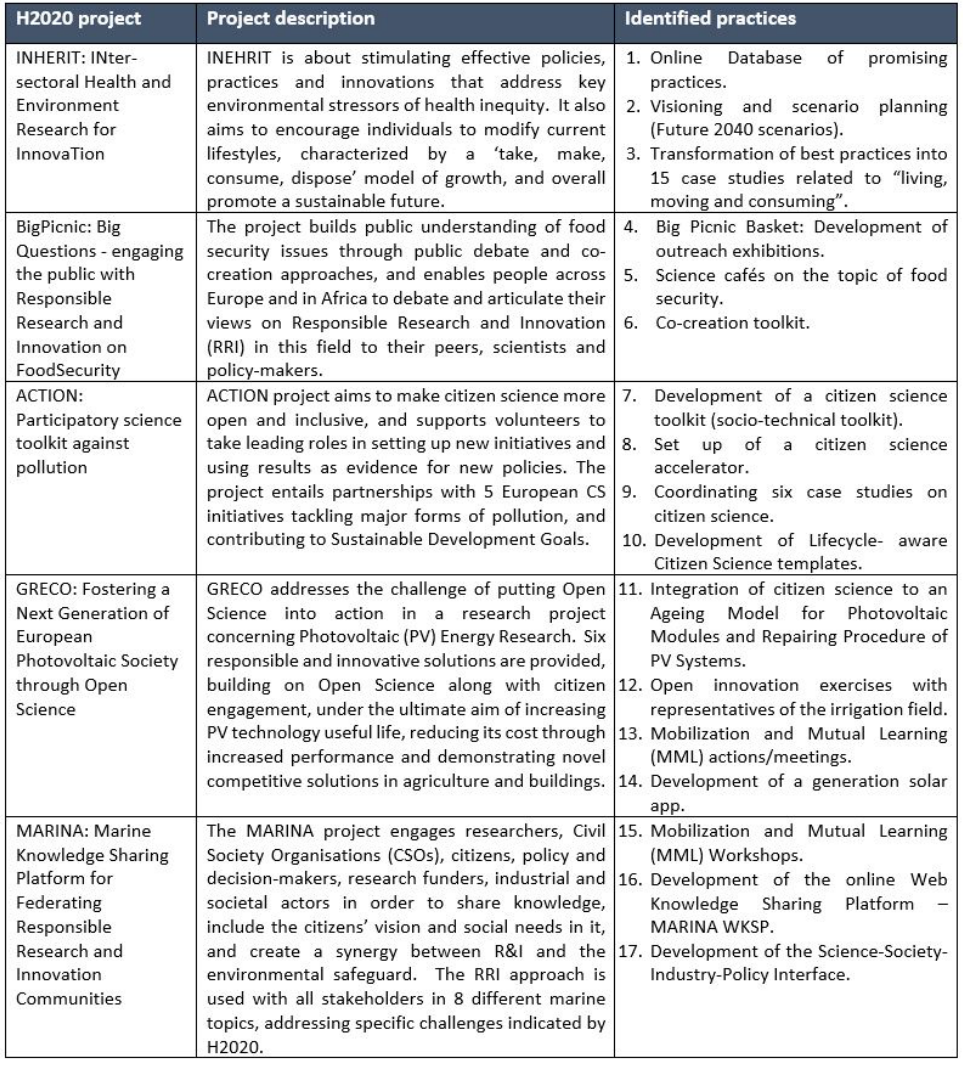
Figure 2. Description of final PE projects and identified PE